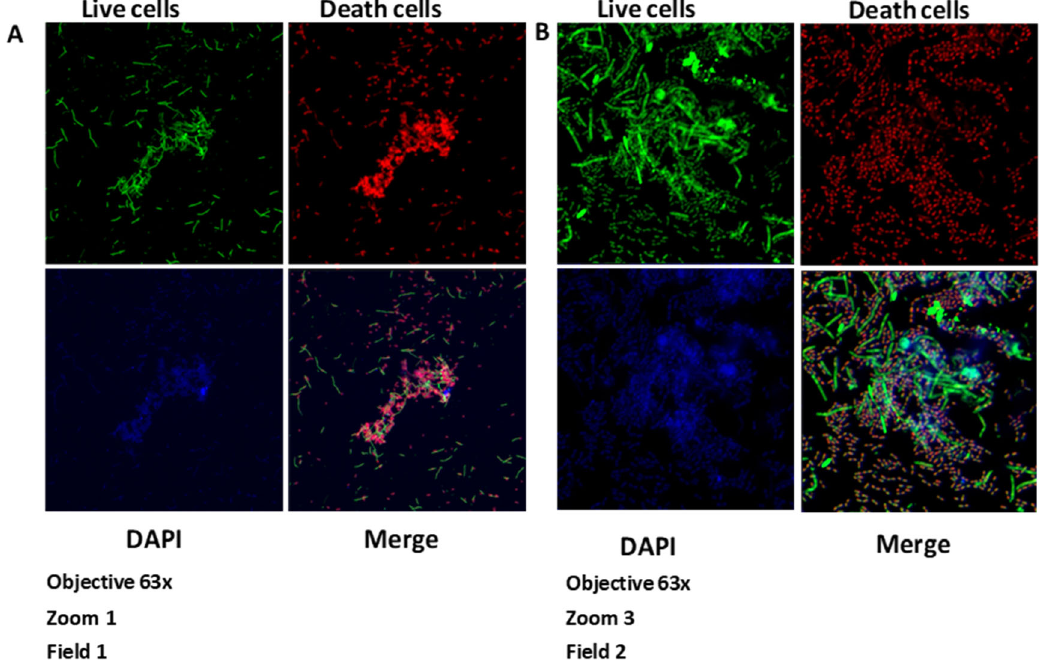
Figure 2. Growth of the biofilm of S. gordonii (ATCC ® 51656 ™ ) and F. nucleatum (ATCC ® 10953 ™ ) at 120 hours. Imagestakenbyconfocalmicroscopy(ZeissLSM880). A)Zoom1.B)Zoom3.DAPI,4 0 ,6-diamidino-2-phenylindole.